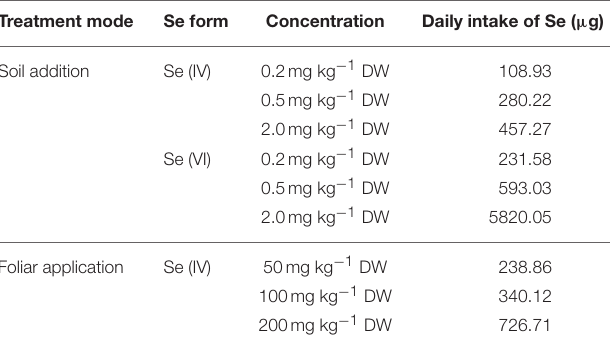
TABLE 3 | Daily intake of Se ( µ g) for adults from fleshy turnip roots.